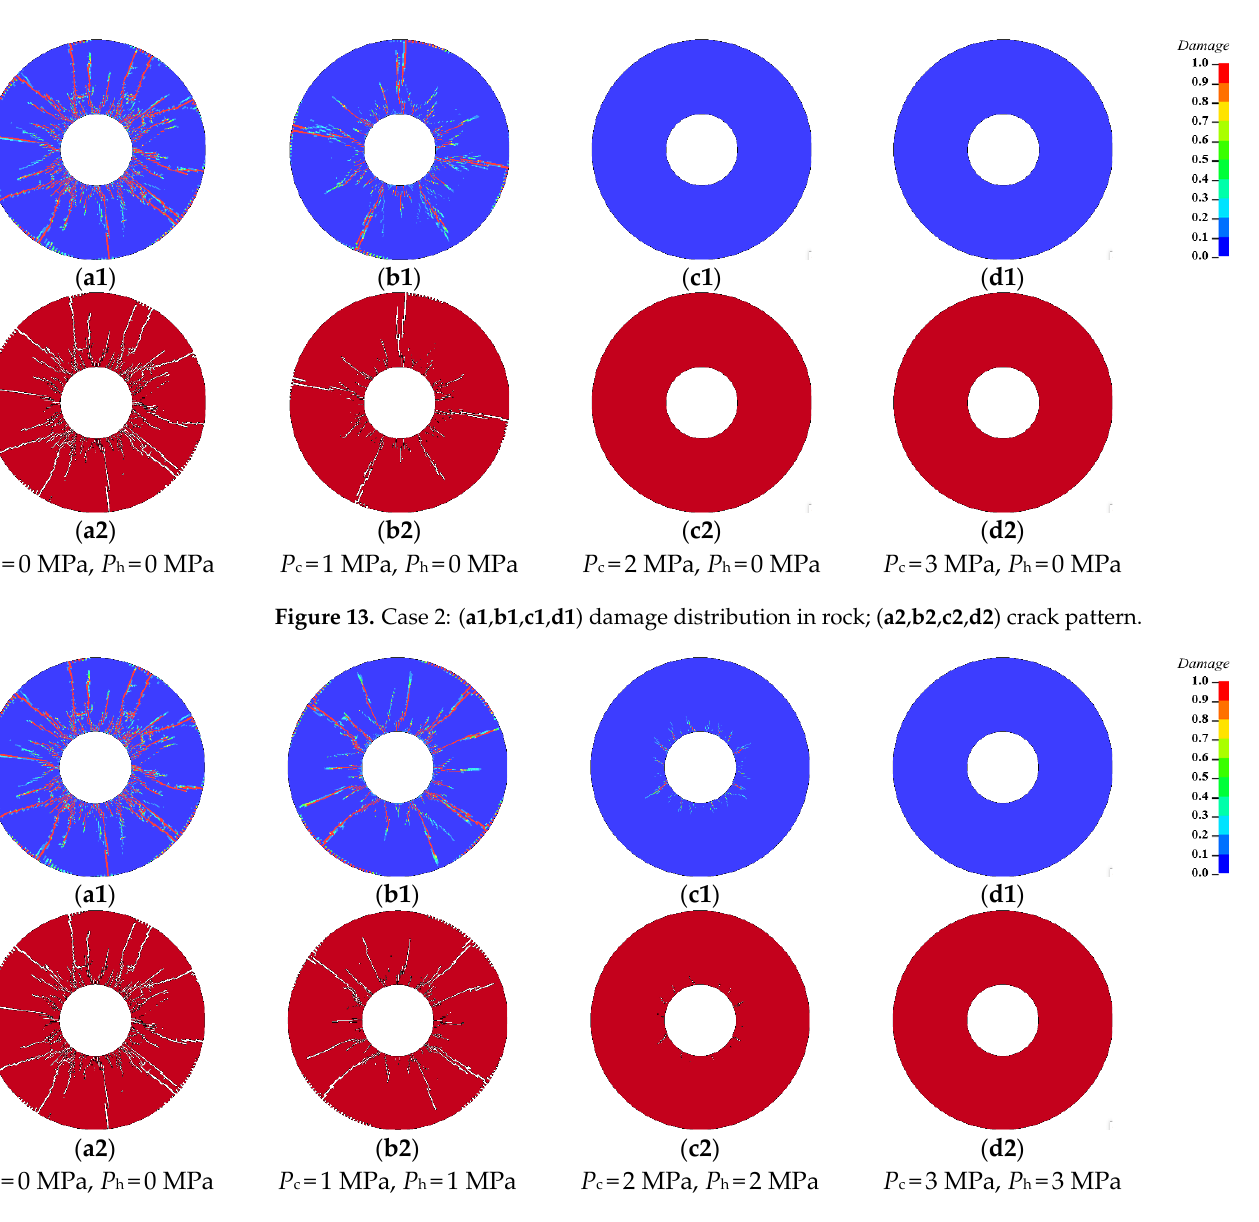
Figure 14. Case 3: ( a1 , b1 , c1 , d1 ) damage distribution in rock; ( a2 , b2 , c2 , d2 ) crack pattern.